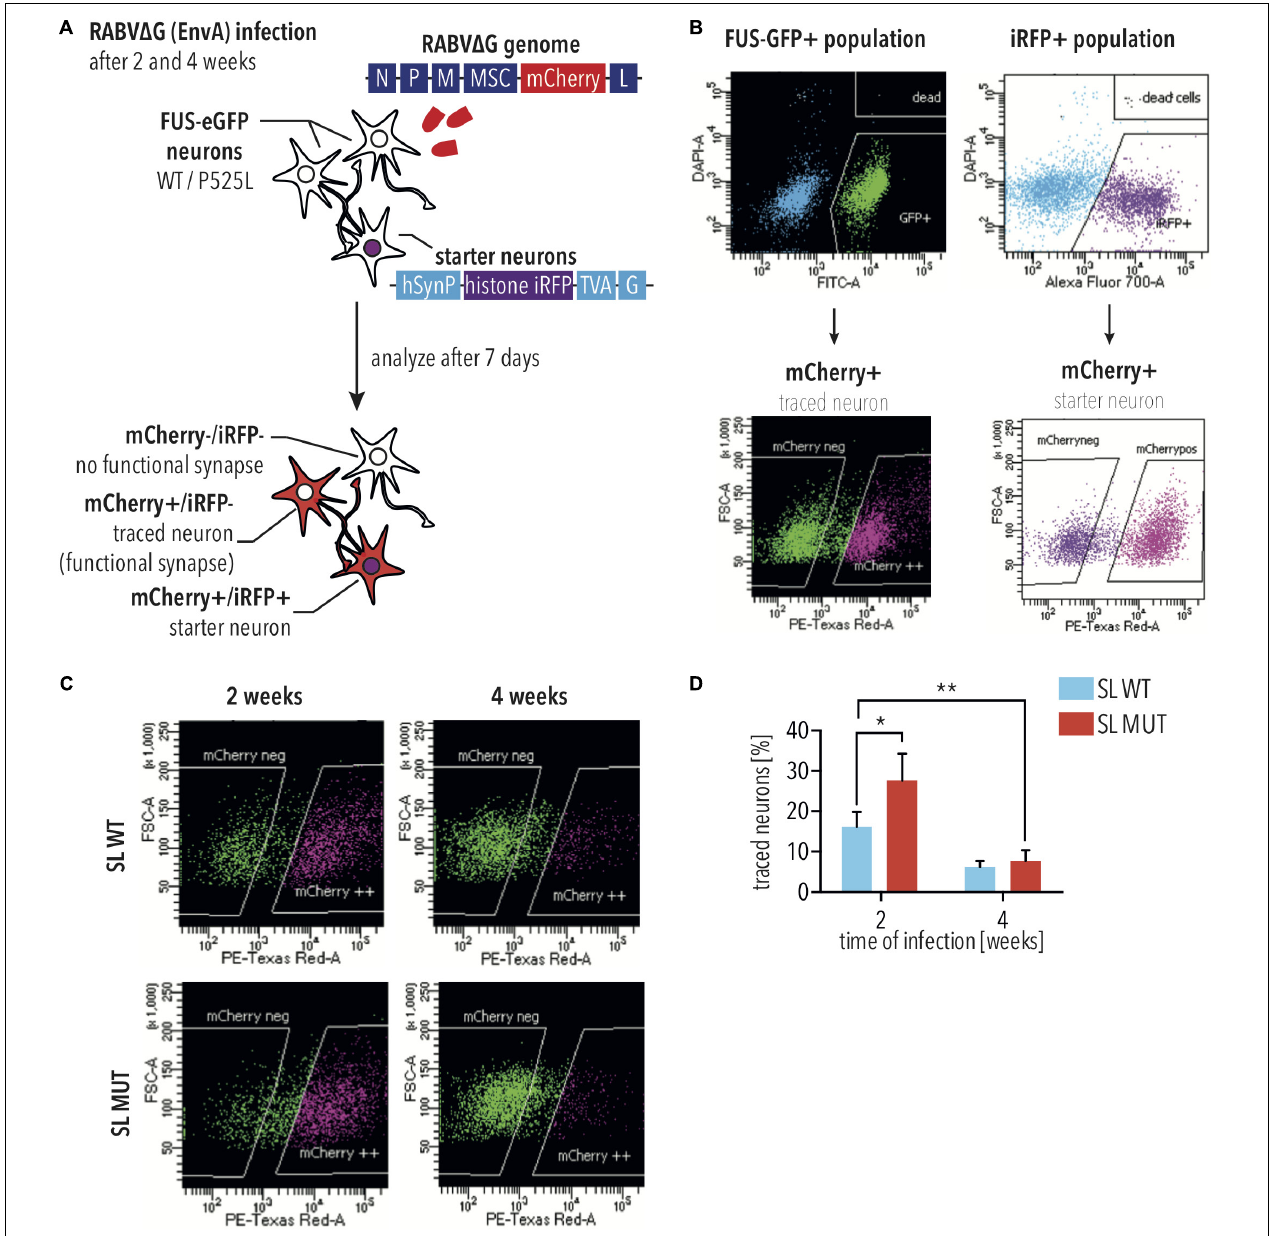
FIGURE 2 | Monosynaptic tracing using RABV (cid:49) G(EnvA) identifies neurodegeneration in FUS-P525L spinal neurons. (A) Diagram illustrating monosynaptic tracing using RABV (cid:49) G(EnvA). Starter neurons express TVA-receptor, H2B-iRFP, and the rabies glycoprotein. Following infection with RABV (cid:49) G(EnvA), starter neurons also express mCherry. (B) Diagram illustrating analysis of monosynaptic tracing using flow cytometry. To quantify traced cells, cells are gated to select GFP- and mCherry-positive cells. To quantify starter cells, cells are gated to select iRFP- and mCherry-positive cells. (C,D) FUS-P525L neurons show lower number of traced cells at 4 weeks ( n = 2) in comparison to earlier timepoints ( n = 4). FUS-P525L neurons show higher mCherry expression when infected 2 weeks after seeding. Error bars indicate SEM. ∗ and ∗∗ correspond to p < 0.05 and 0.01, respectively. SL, short linker; MUT, mutant; WT, wild type; histone iRFP, H2B-iRFP.